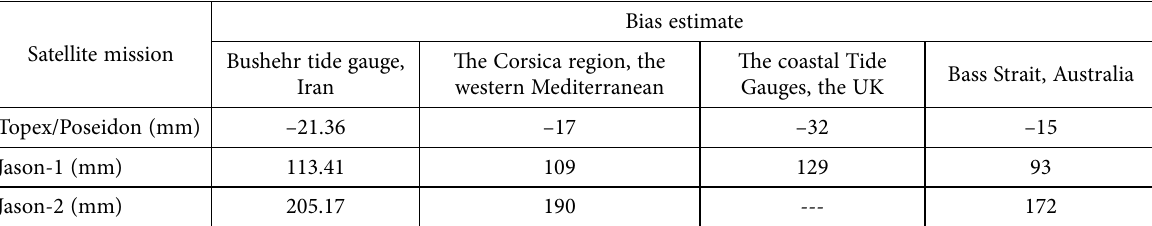
Table 10. Comparison of the estimated results at Bushehr port with those in the Corsica region of the western Mediterranean, the UK and Bass Strait in Australia